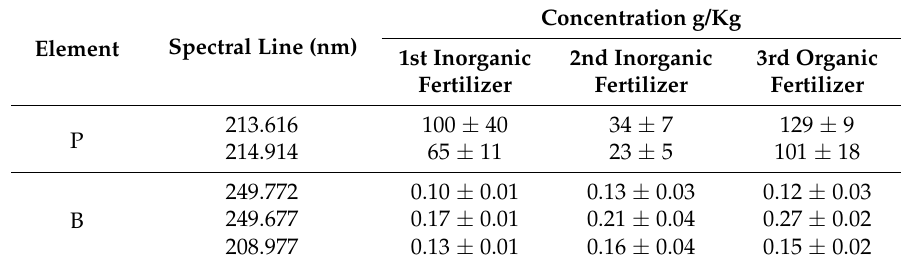
Table 10. Concentration of P and B in fertilizer samples found by ICP-AES analysis after digestion. Element Spectral Line (nm)